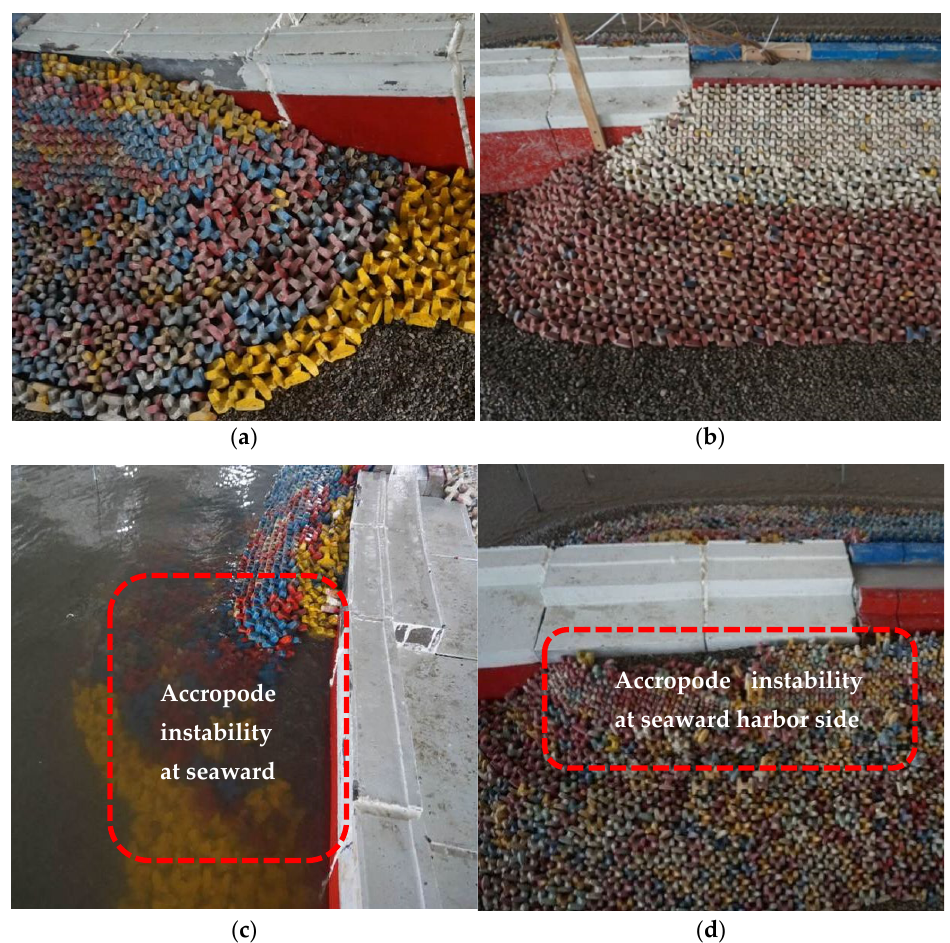
Figure 9. Comparison of the stability of the armor block before and after the test. ( a ) Block placement before testing at sea side; ( c ) Instability of block after testing at sea side; ( b ) Block placement before testing at harbor side; ( d ) Instability of block after testing at harbor side. Table 7. Stability weight of Accropode tested and calculated under different wave